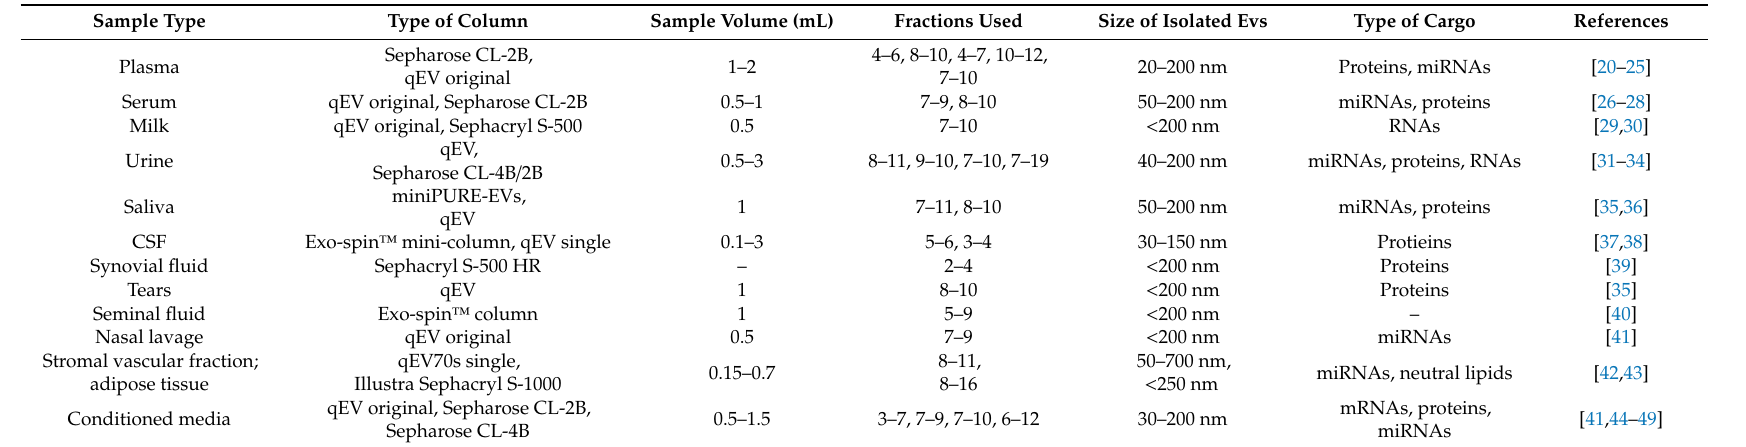
Table 2. Overview of exosome isolation from di ff erent biological sample types using size exclusion chromatography (SEC). This table summarizes the recent publications that used SEC to isolate exosomes. Shown are the various biological fluids, types of SEC columns used, starting sample volume, fractions that contained exosomes, size of isolated exosomes, and type of cargo enriched in the isolated vesicles. Some of the listed studies isolated exosomes using SEC alone or in combination with other methods. All included papers performed exosome characterization in accordance with MISEV 2018